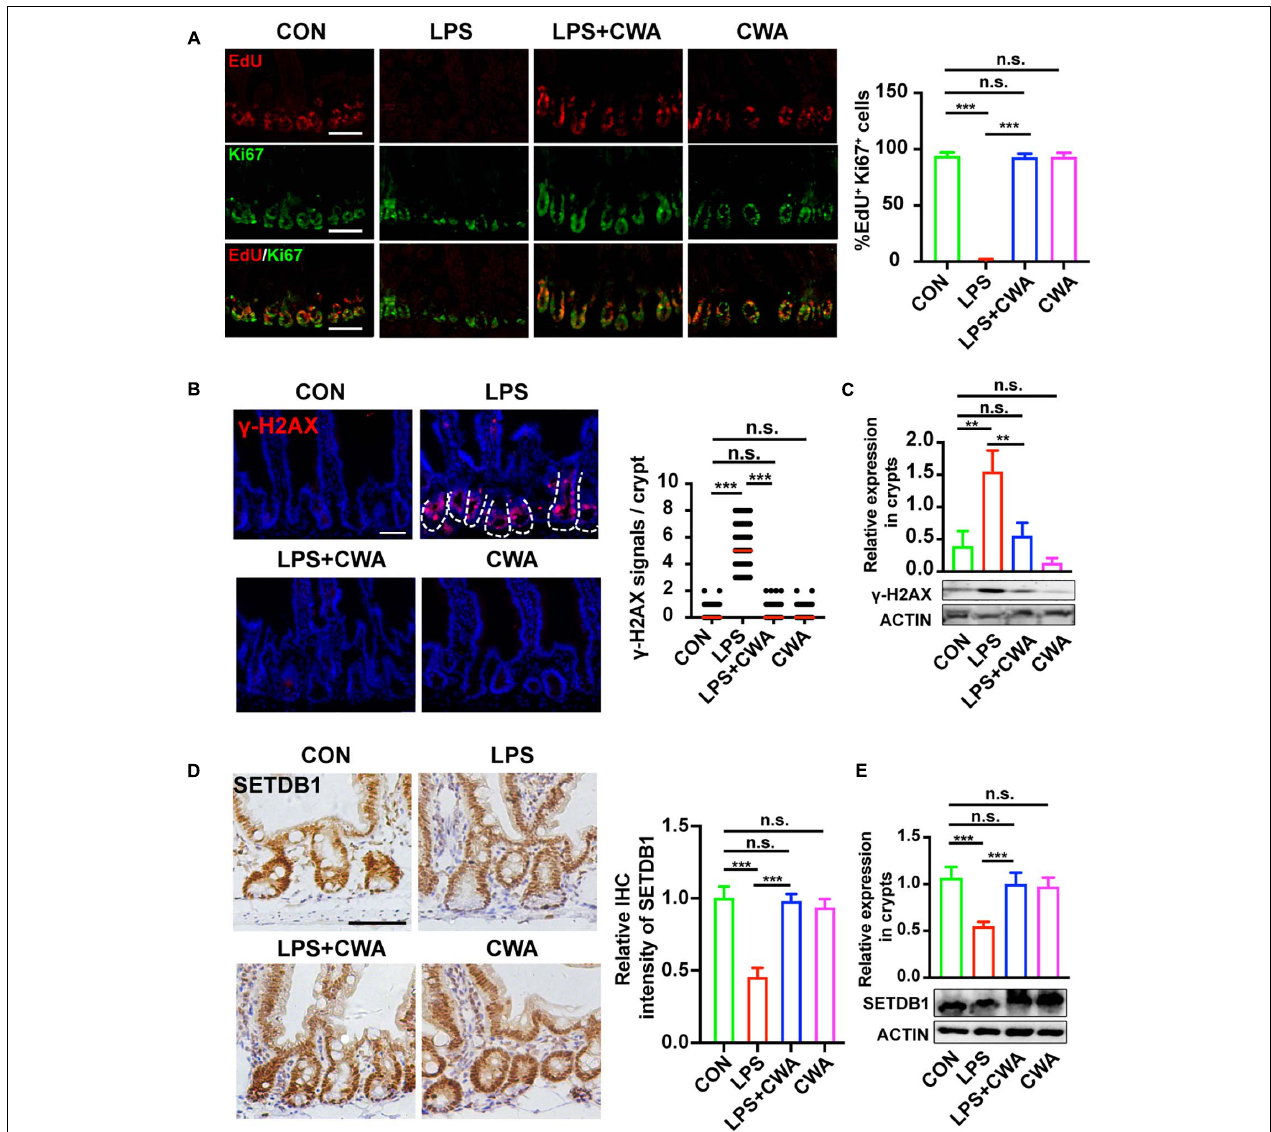
FIGURE 5 | CWA suppresses the genome instability. (A) Representative image of co-stained EdU and Ki67 in SI crypts. EdU was allowed to incorporate for 4 h before harvest. The graph in the right is the statistical analysis of overlapped EdU and Ki67 cells. (B) Representative immunofluorescence images of γ -H2AX expression in crypt at 24 h after CWA administration and numbers of γ H2AX + cells in crypts. (C) Western blot analysis of γ -H2AX expression in crypts. (D) Representative IHC image of SETDB1 expression at 24 h after CWA administration and analysis of SETDB1 IHC intensity. (E) Western blot analysis of SETDB1 expression in crypts. Scale bars, 100 µ m. *** P < 0.001, ** p < 0.01 by two-sided, unpaired t -test. All data represent at least three independent experiments.